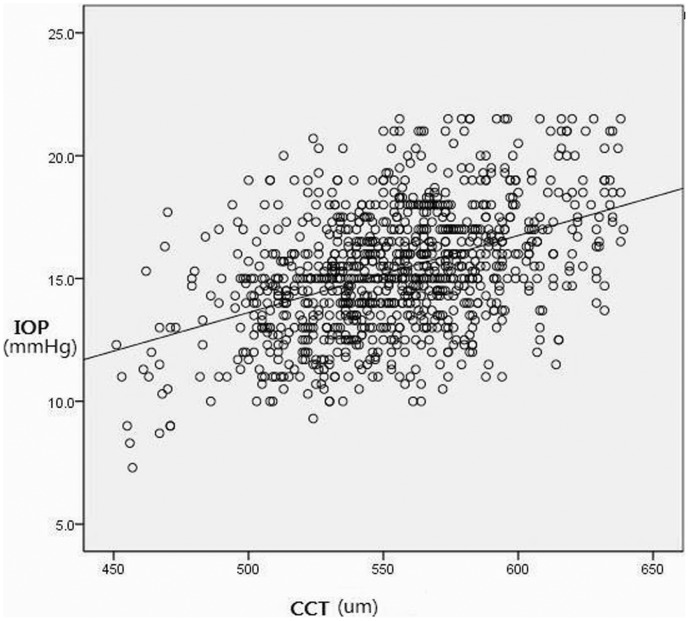
Scattergram of central corneal thickness (CCT) versus intraocular pressure (IOP) of children aged 7 to 18years (r = 0.44, n = 982).